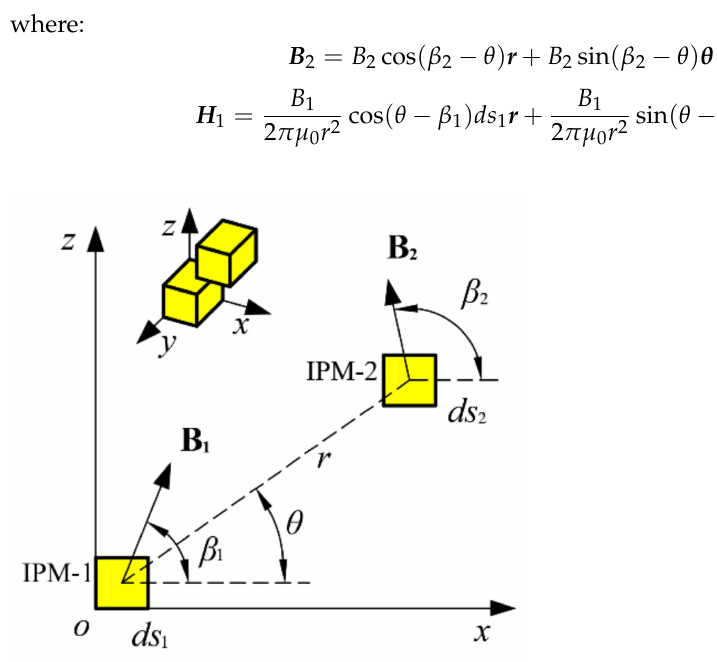
Figure 5. Schematic diagram of infinitesimals of permanent magnet (IPM)-1 and